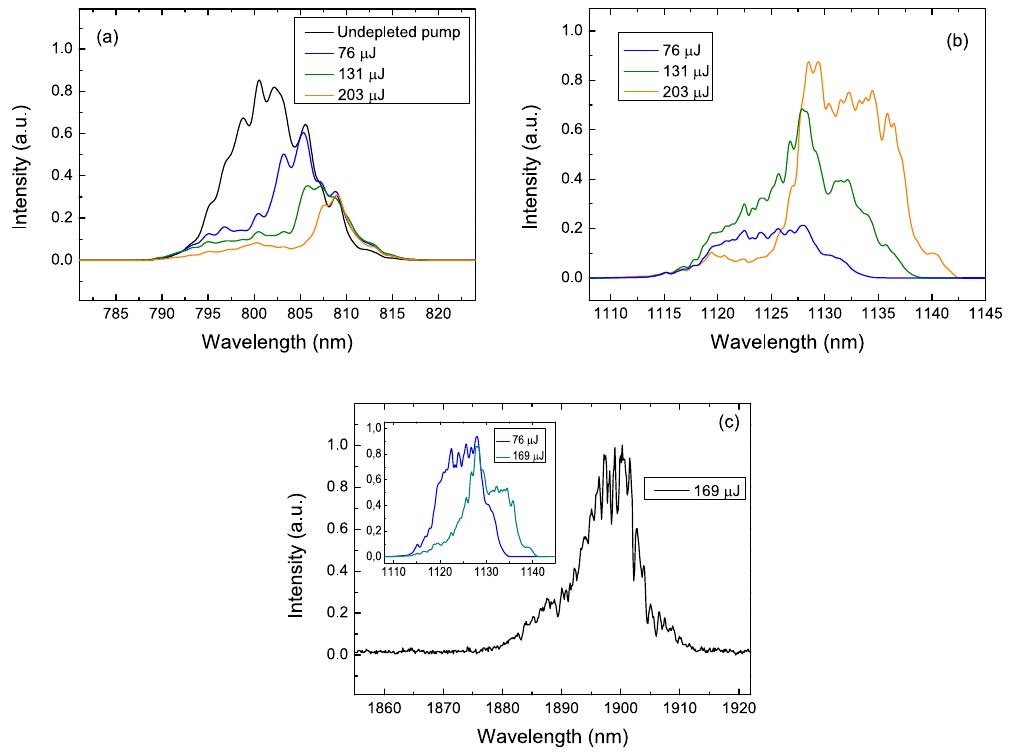
Figure 5. Pump and signal spectra. Spectra of ( a ) the pump, ( b ) s1 and ( c ) s2 at different pump energies, shown in the figures legends. Inset in ( c ) – Normalized s1 spectra at different pump energies, showing s1